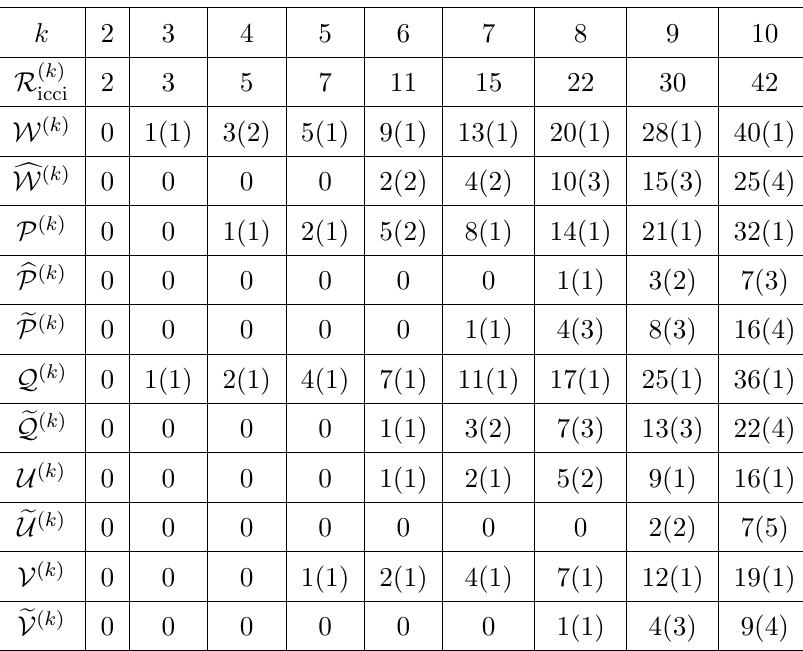
Table 2 . The total number of linearly-independent quasi-topological polynomials for a given order in each series. The number in parenthesis denotes the number of irreducible solutions which are presented in appendix